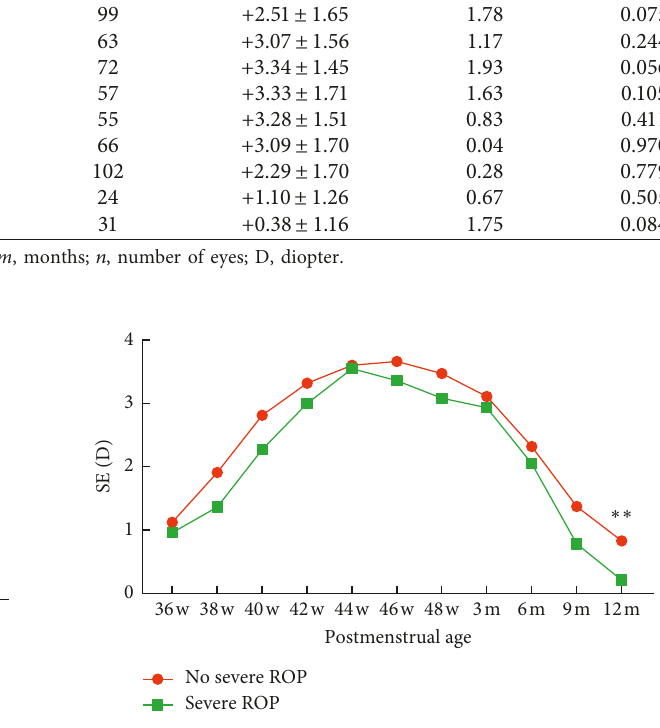
Figure 5: Correlation between SE and ROP. SE, spherical equivalent; D, diopter. Table 6: SE of the presence or absence of serious ROP.